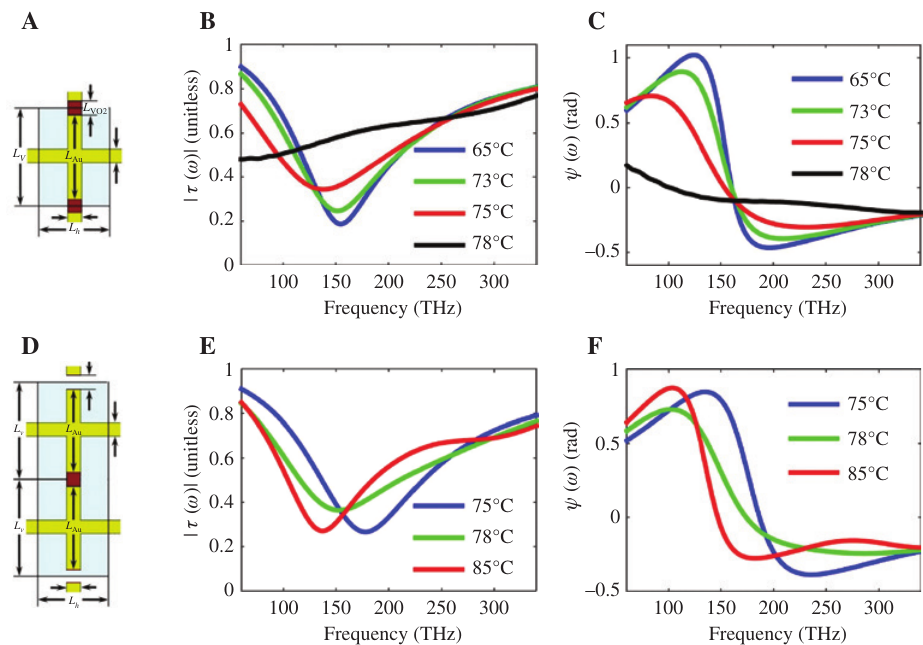
Figure 2: (A) Proposed metasurface for thermal controlling of band-stop optical filter’s dip strength. Panels (B) and (C) are transmission coefficient’s amplitude and phase of panel (A) in several temperatures. (D) Proposed metasurface for thermal shifting of stop resonance. Transmission coefficient’s amplitude (C) and phase (D) for this metasurface in different